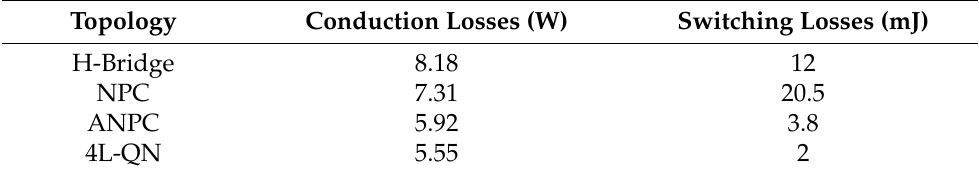
Table 4. Semiconductor switches